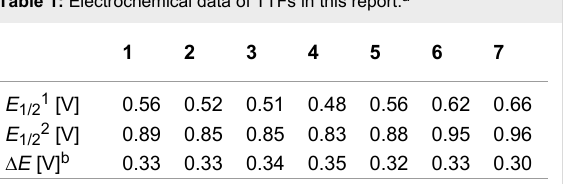
Table 1: Electrochemical data of TTFs in this report.